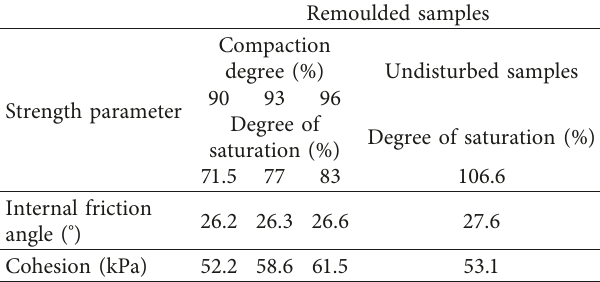
Table 2: Strength parameters of the red clay under different compaction